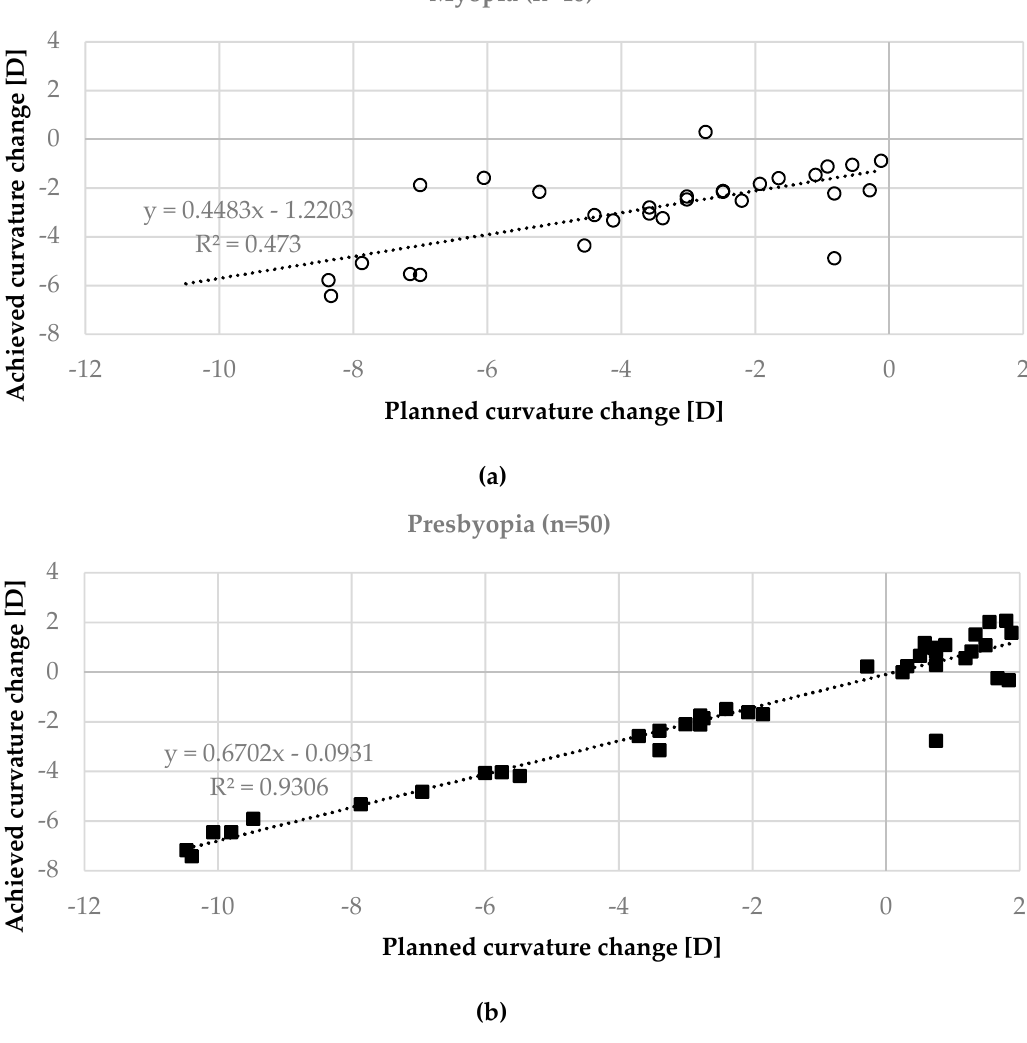
Figure 3. Comparing planned to achieved shape change of anterior corneal surface. Presbyopia treatments ( b ) showed a better match (R 2 = 0.93 and slope 0.67) than ( a ) myopia (R 2 = 0.45 and slope 0.47).